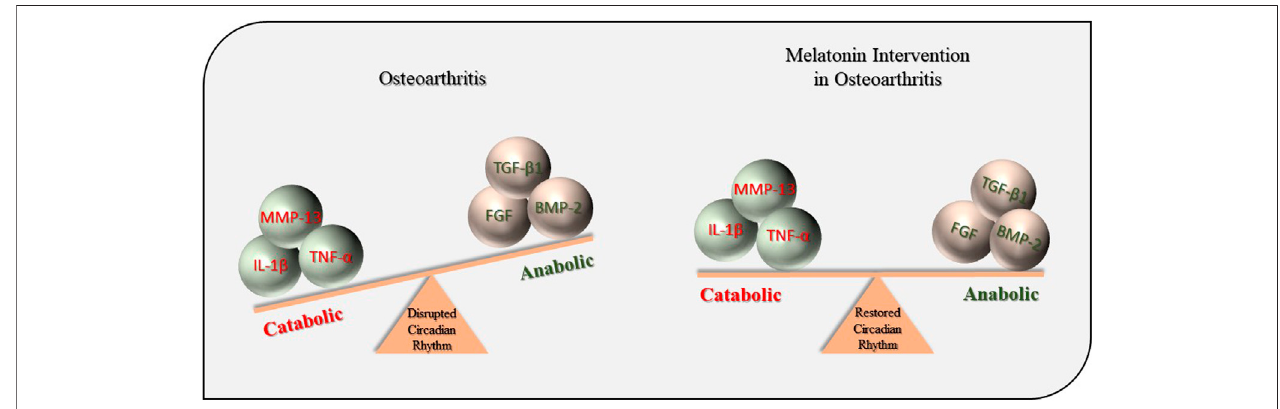
FIGURE 8 | Protective effects of MT during OA pathogenesis. MT, melatonin; OA, osteoarthritis; IL-1 β , interleukin-1 β ; TNF- α , tumor necrosis factor- α ; MMP-13, matrix metalloproteinase-13; TGF- β 1, transforming growth factor- β 1; FGF, fi broblast growth factors; BMP-2, bone morphogenetic protein-2.